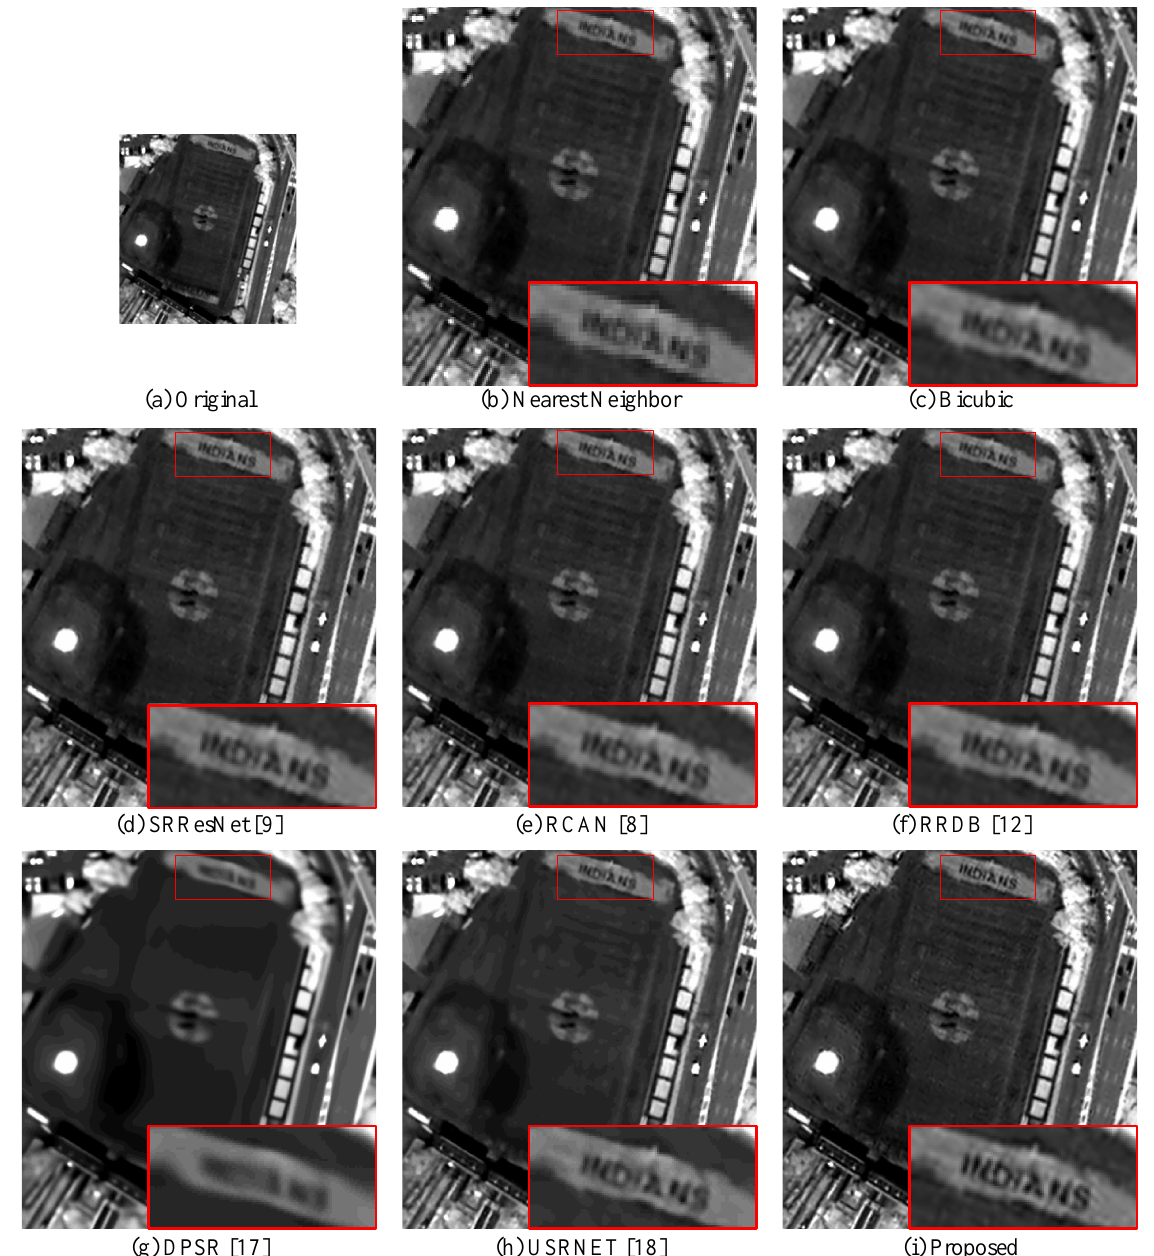
Figure 7. Visual qualitative comparisons of the proposed method with other SR methods on a panchromatic image, Weehawken Stadium,